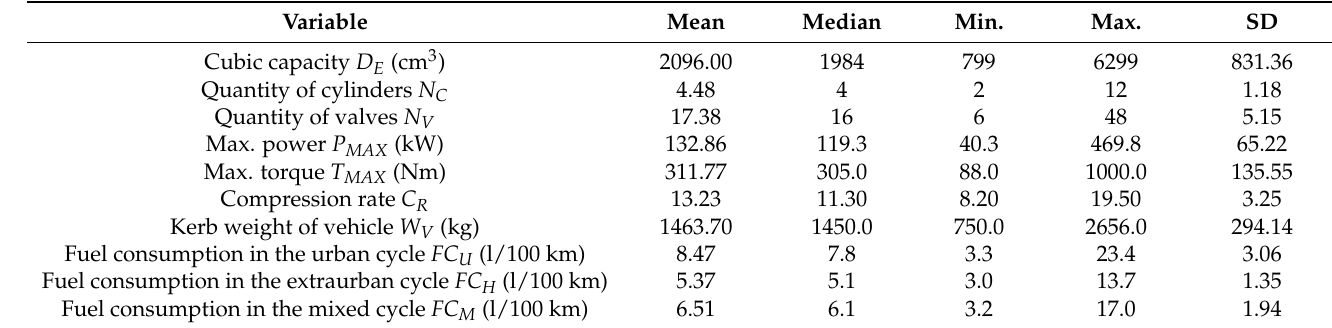
Table 3. Statistics on the quantitative variables.